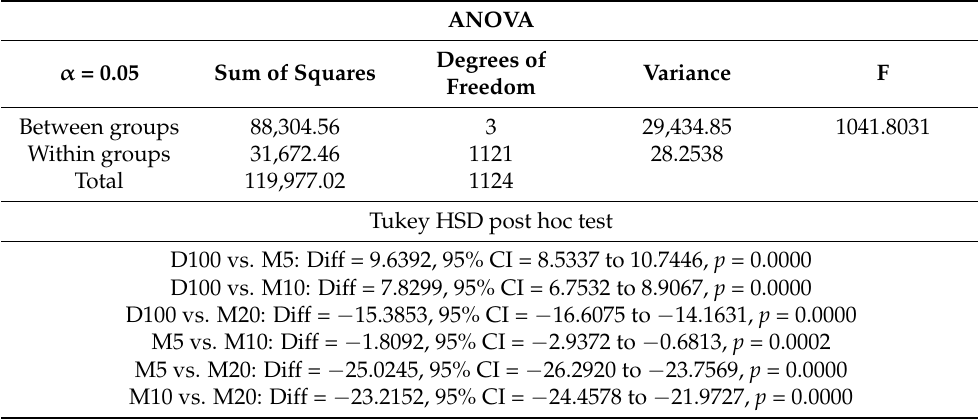
Table 8. Results of ANOVA with Tukey HSD post hoc test for CO 2 at the measurement point 2.